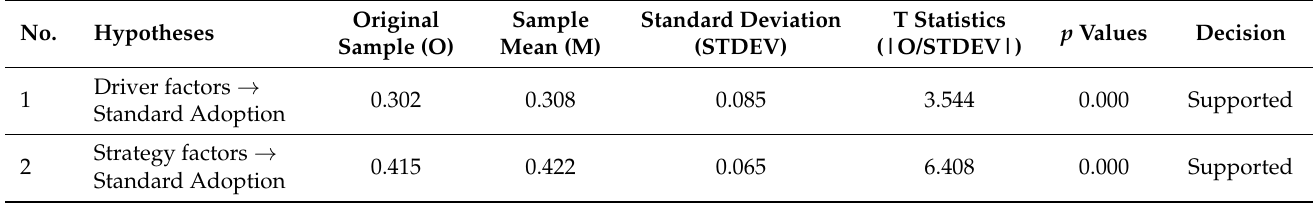
Table 7. Path coefficient of the research hypotheses.